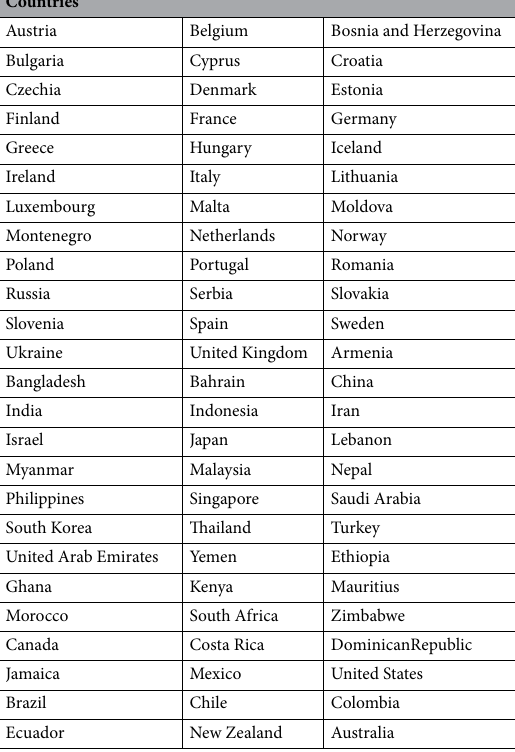
Table 2. List of input countries.